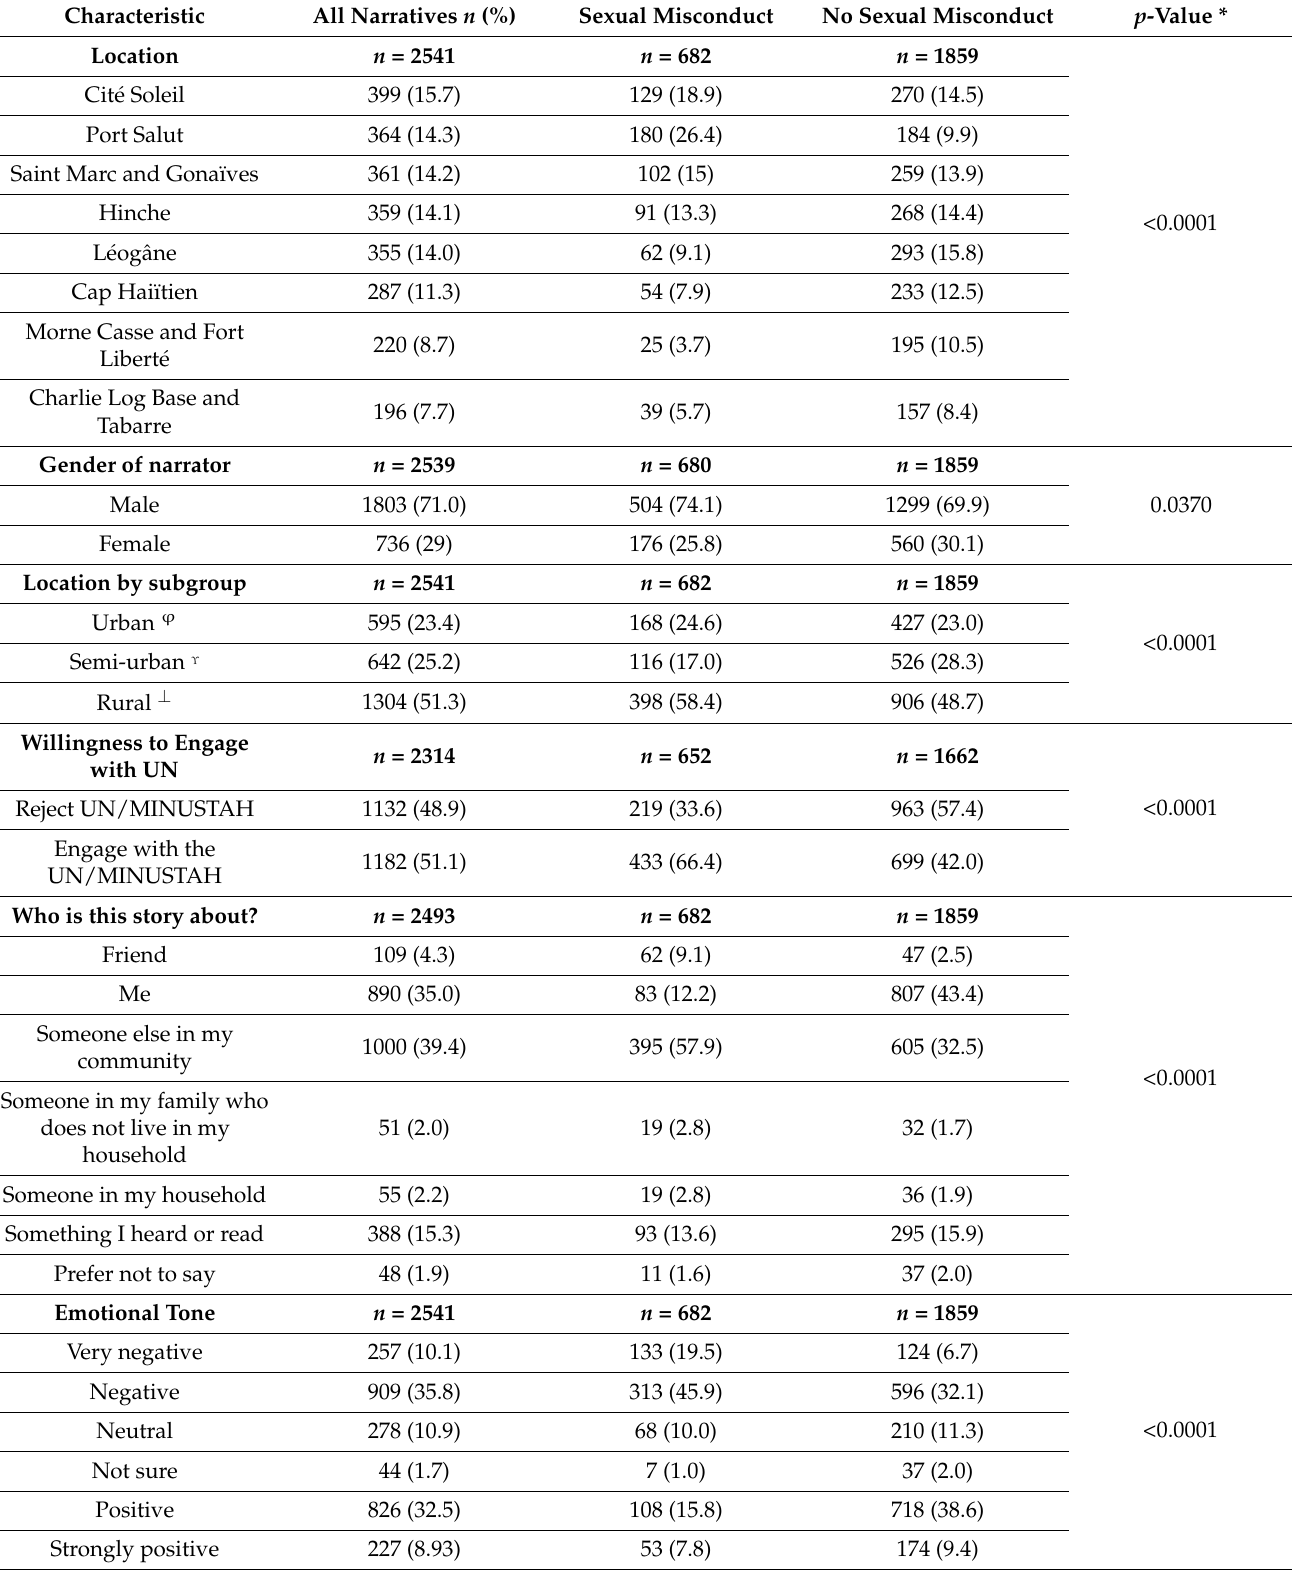
Table 3. Characteristics of the narratives shared.